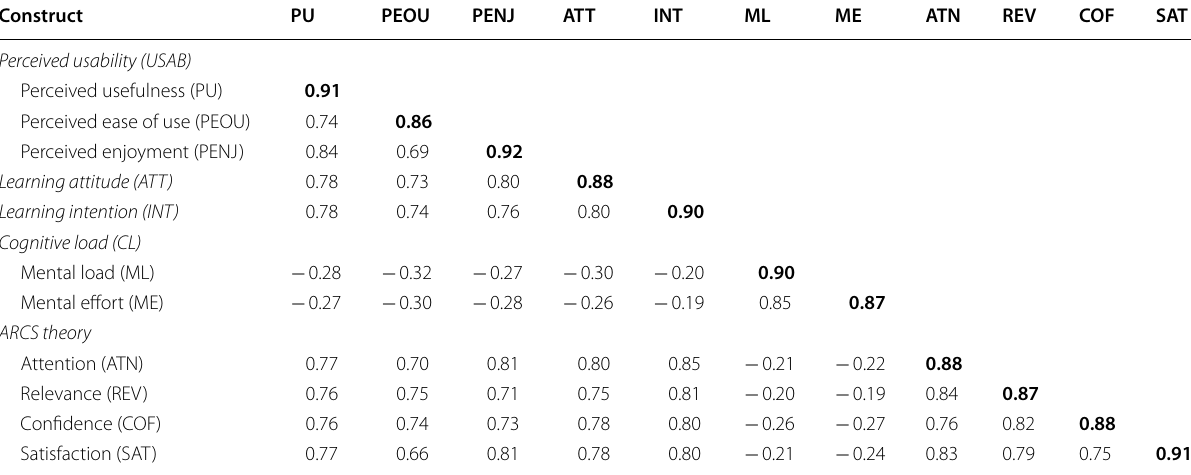
Table 3 Fornell–Larcker discriminant validity results Construct